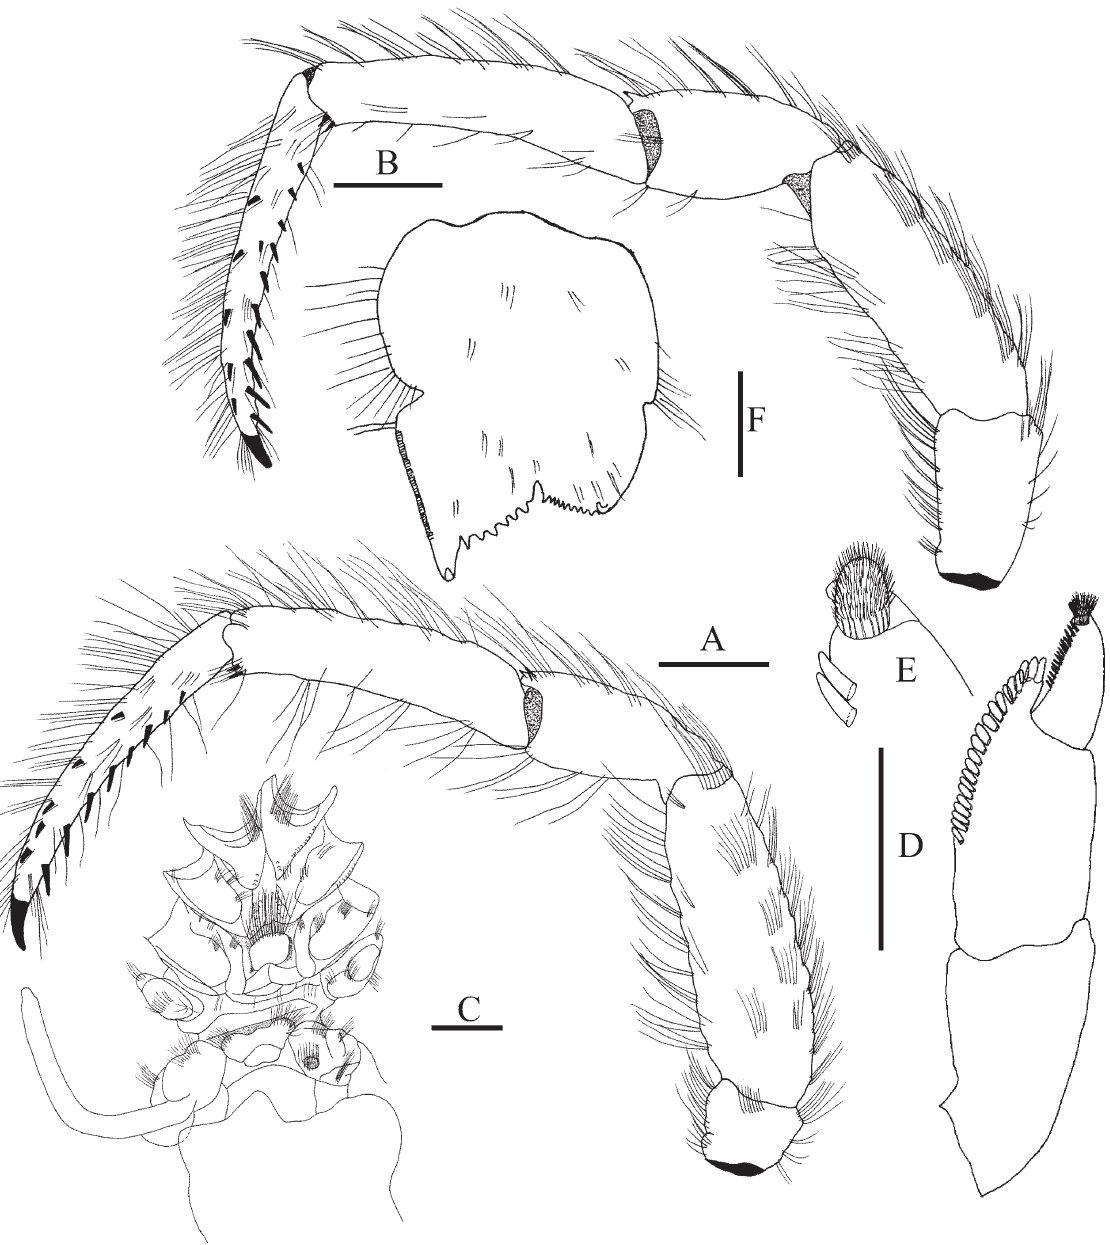
long setae. Ischium with row of small spines or spinules on ventromesial margin; ventrolaterodistal margin with 1 strong spine. Second and third pereopods (Figs. 7A, B, 8D, E) similar in armature; dactyls 1.2-1.3 longer